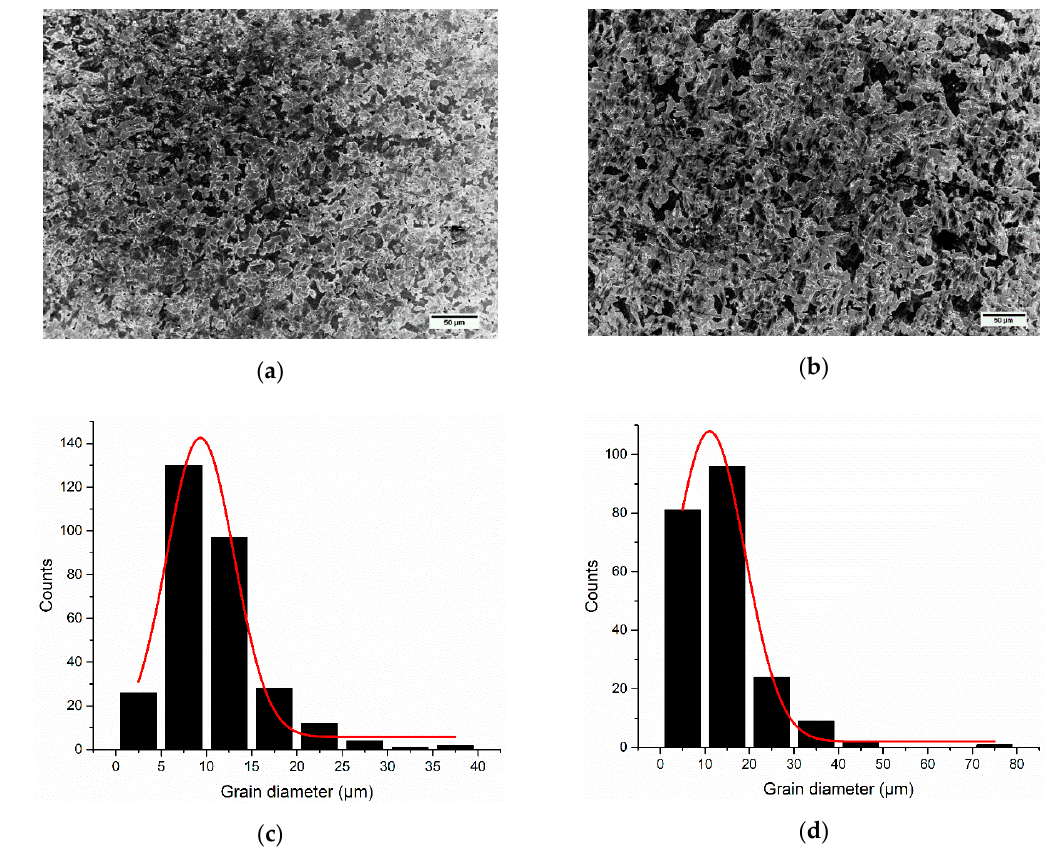
Figure 6. Microstructure attained by an SEM with a slight difference in grain size for the ( a ) intralayer and ( b ) interlayer microstructure. Histogram of grain diameter for the ( c ) intralayer and ( d ) interlayer microstructure.